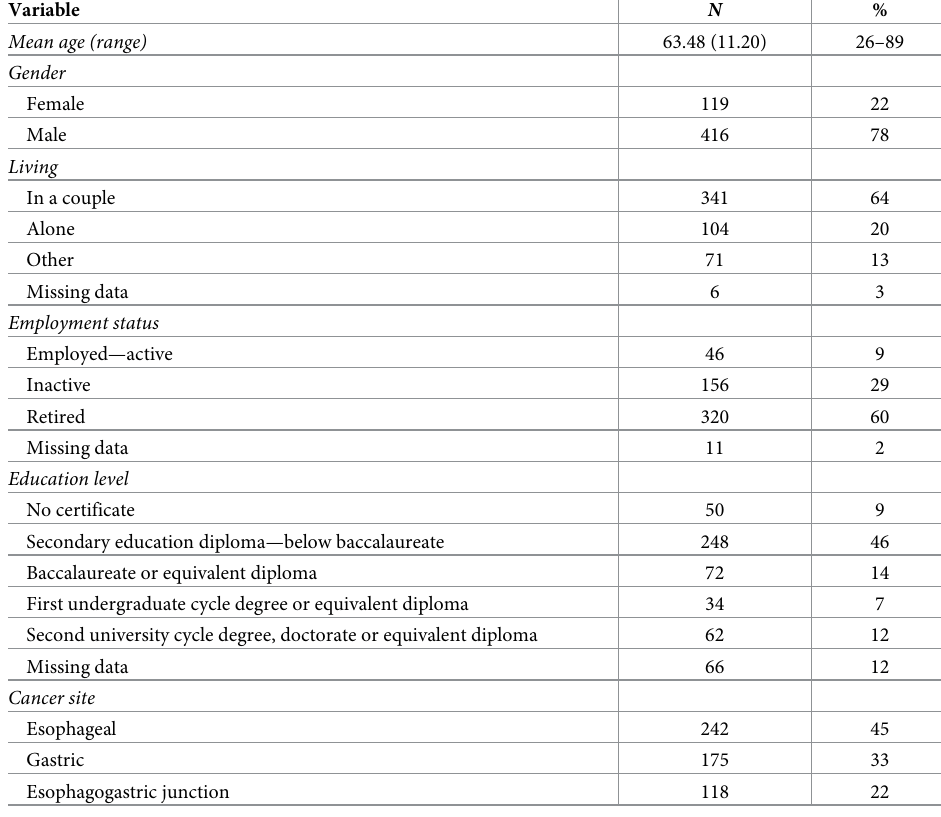
Table 1. Sample characteristics ( N =